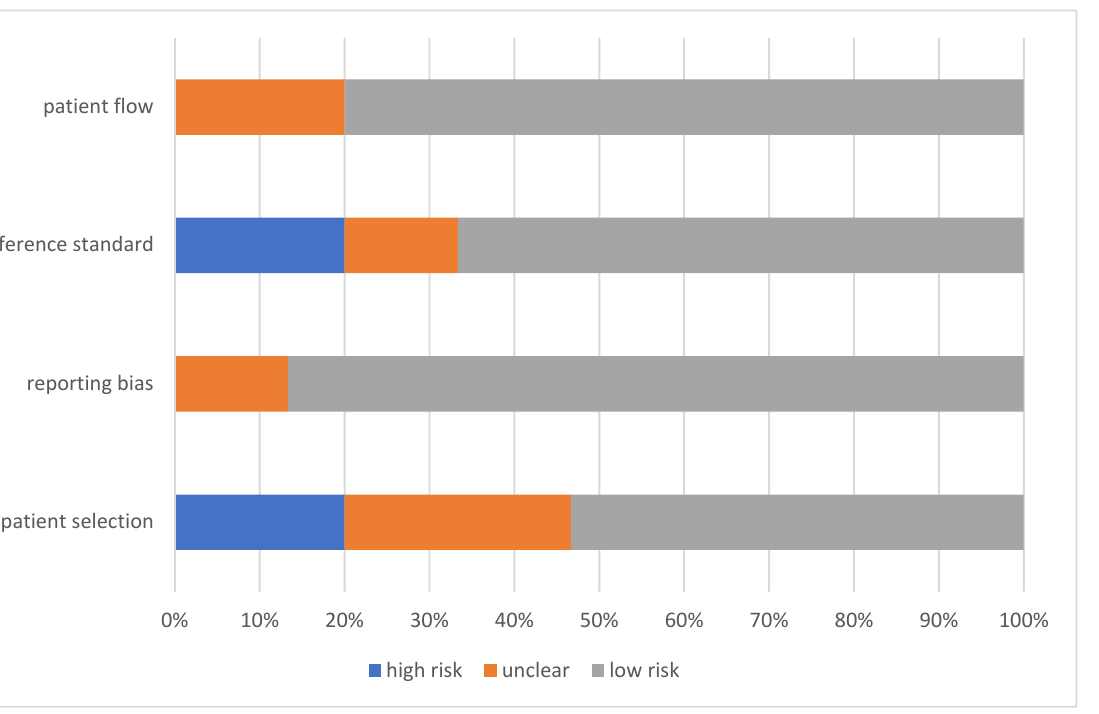
Figure 2. QUADAS-2 score for the risk of bias across all studies for the included studies in the systematic review of cut-off values for troponin in patients with chronic kidney disease.